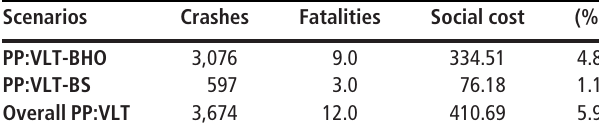
Table VI Crashes, fatalities and social cost of PP:VLT